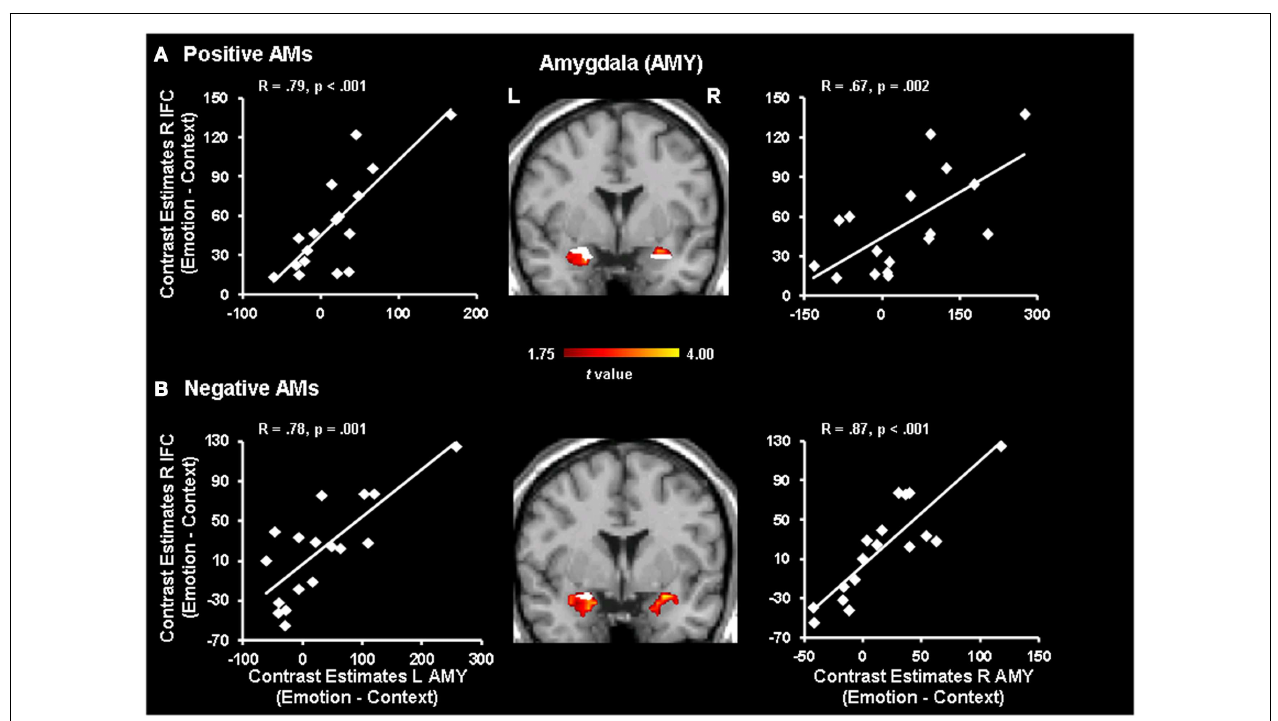
areas showing significant increase in activity for Emotion vs. Context focus. The gradient color bar starts at p < 0.05 ( t = 1.75). Similar patterns of correlations were observed in the left IFC (not shown, see text).The scatterplots are based on contrast estimates for Emotion vs. Context extracted from the peak voxel of the areas showing the co-variation with AMY activity. L, left; R,